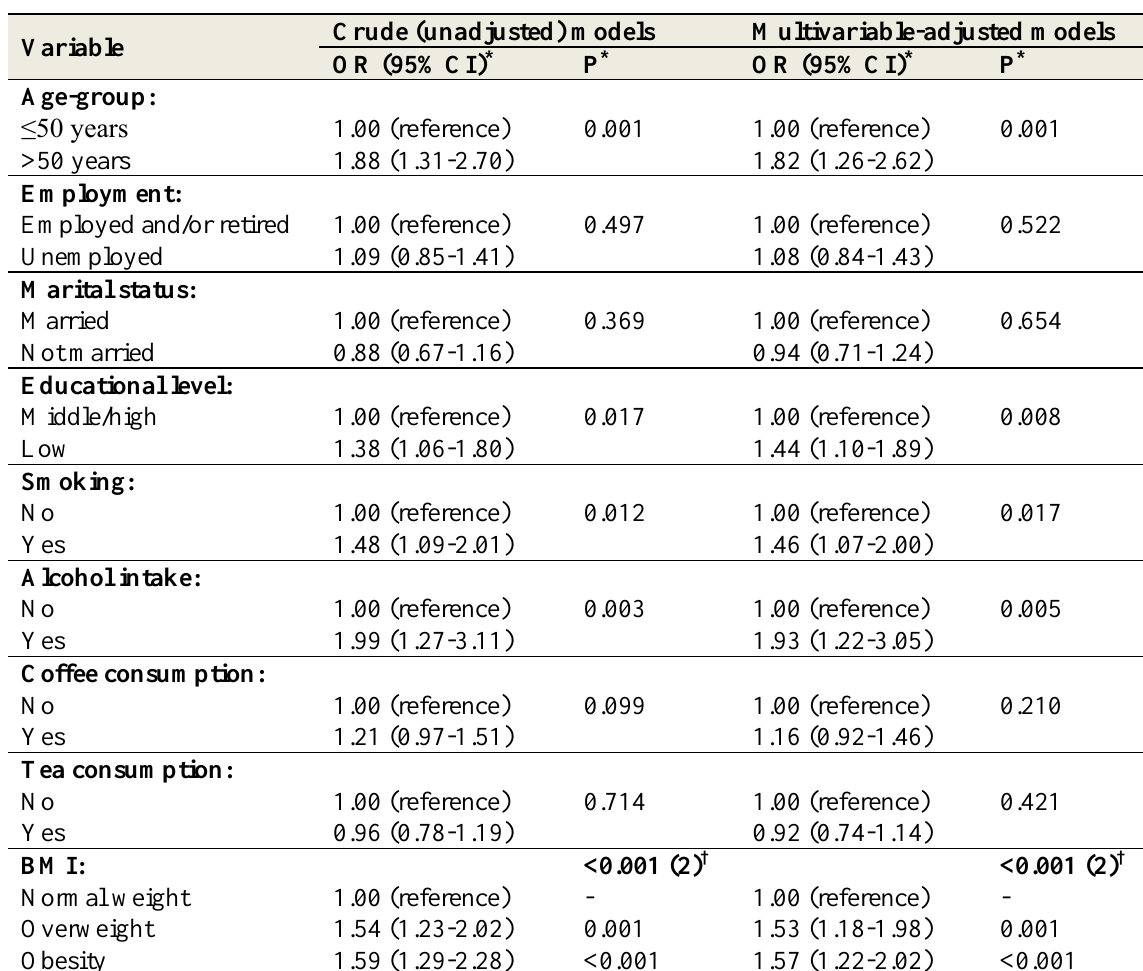
Table 2. Association of rheumatoid arthritis with socio-demographic characteristics and